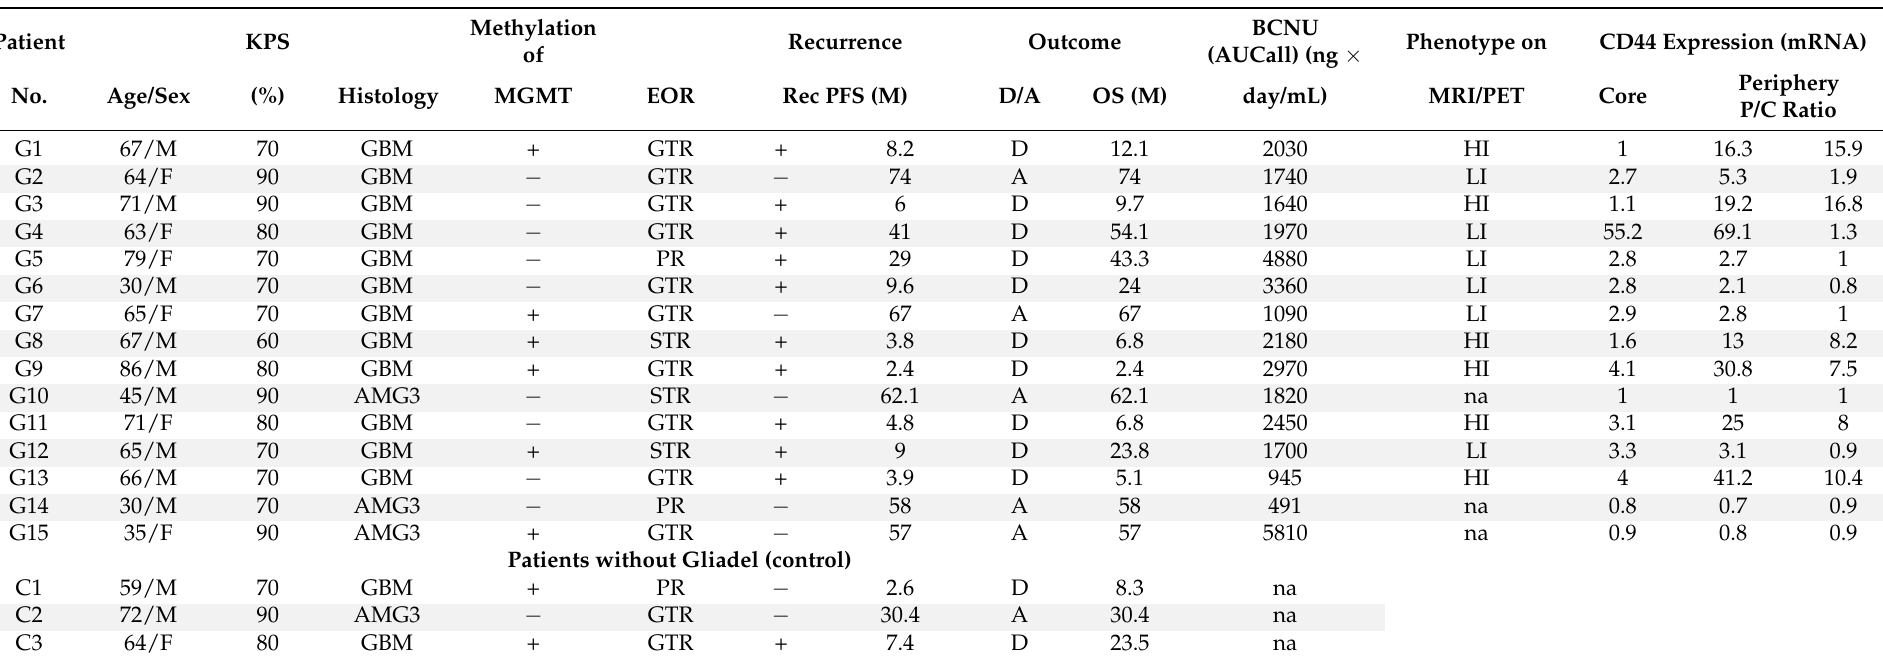
Table 1. Characteristic features, outcome, concentrations of BCNU, tumor phenotypes, and expression of CD44 in the glioma patients with Gliadel wafer